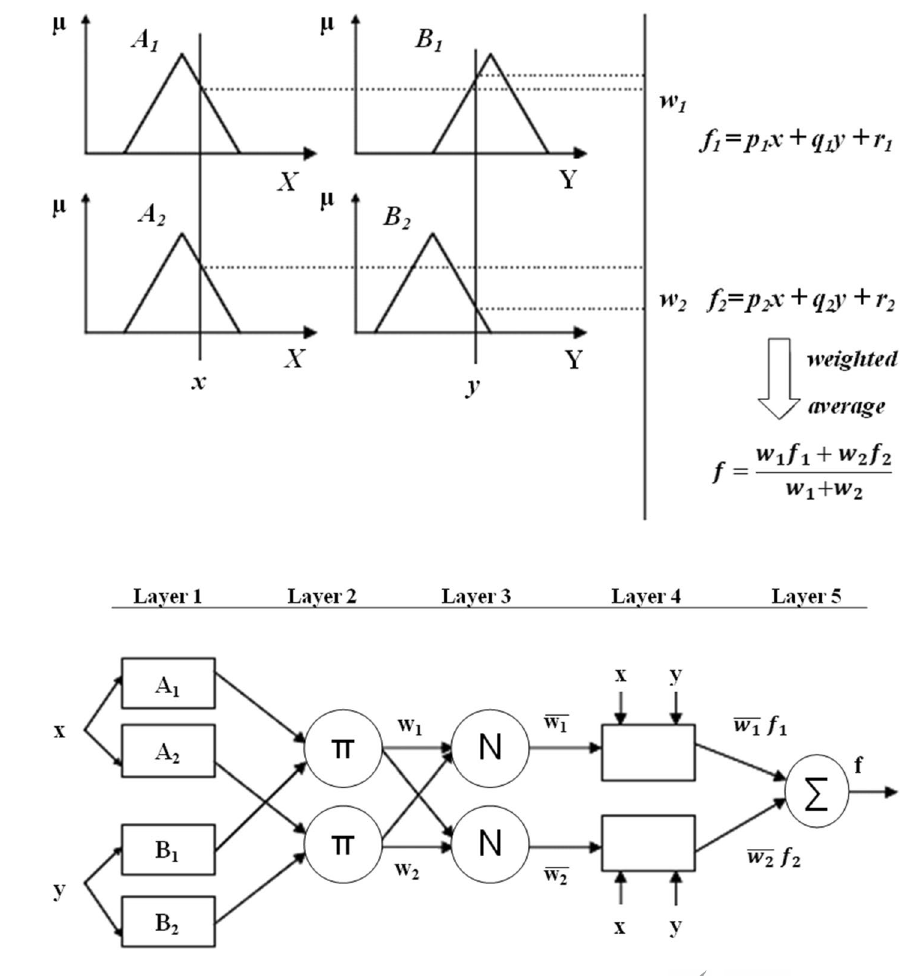
Fig. 13 Two inputs of first-order Sugeno fuzzy model with two rules